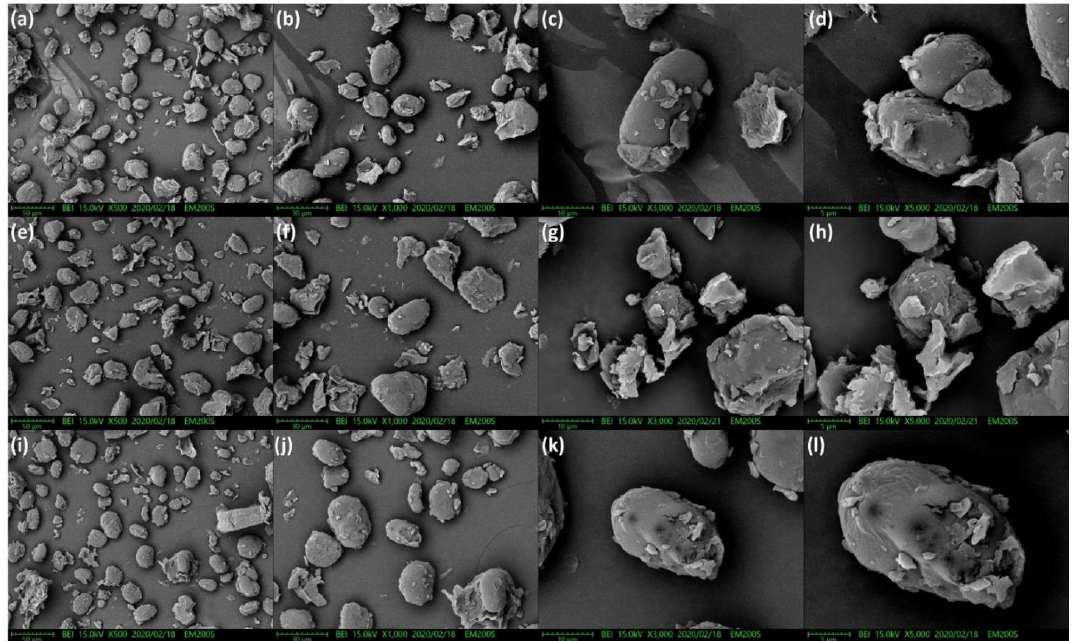
Figure 3. Scanning electron micrographs of starches from pigeon pea milk, ( a – d ) control; ( e – h ) HTST; and ( i – l ) HPP. and ( i – l )